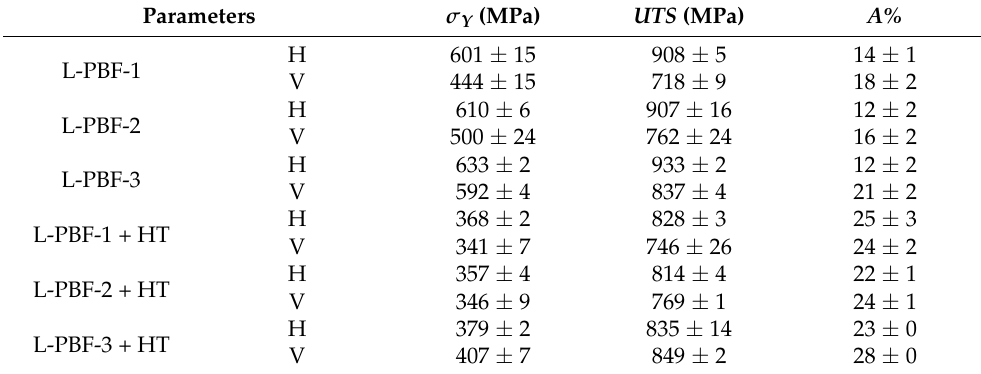
Table 4. Mechanical properties of as-built and heat-treated L-PBF samples (H = horizontal direction perpendicular to the building direction (BD); V= vertical direction parallel to the BD). Two samples were tested for each